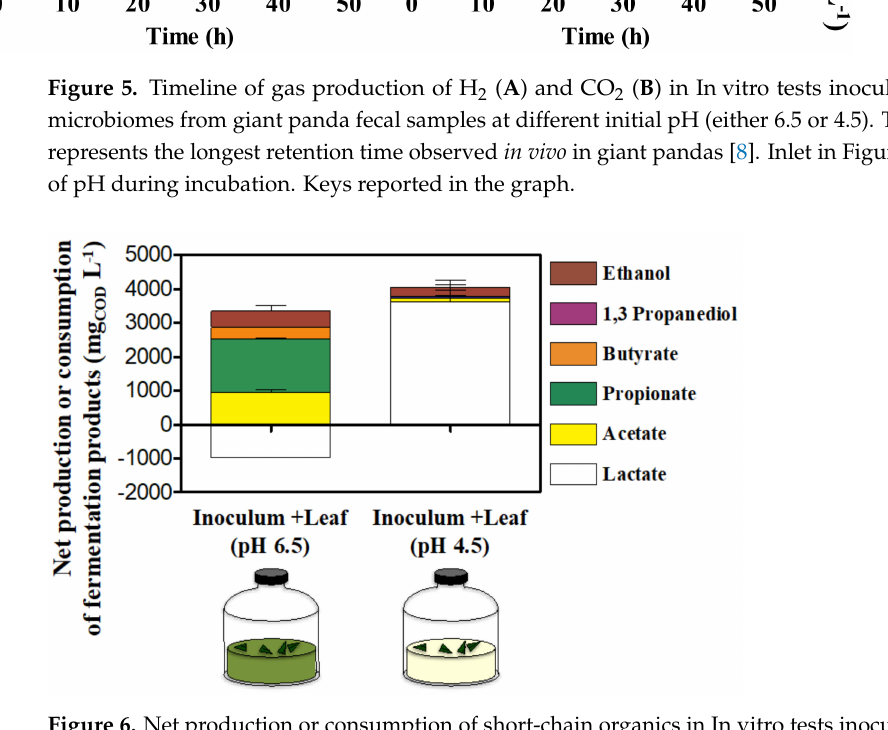
Figure 6. Net production or consumption of short-chain organics in In vitro tests inoculated with gut microbiomes from giant panda fecal samples at different initial pH (either 6.5 or 4.5) after 52 h. Keys reported in the